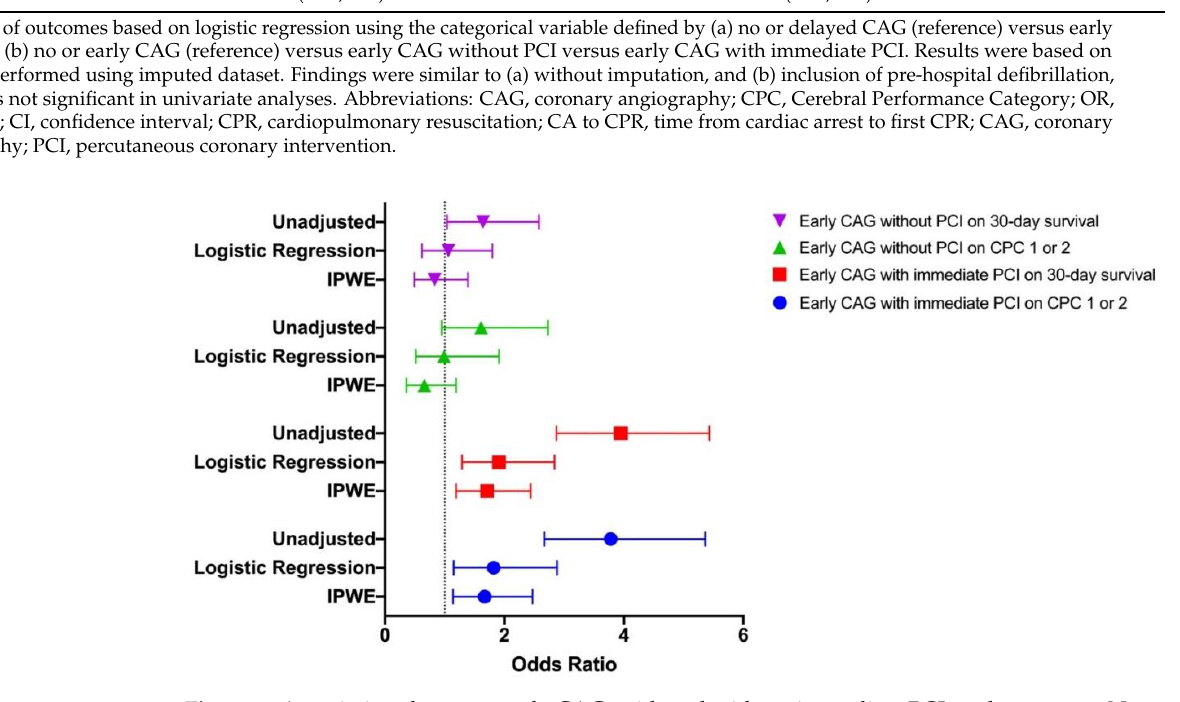
Figure 3. Associations between early CAG, with and without immediate PCI, and outcomes. No or delayed CAG was taken as the reference group. Abbreviations: CAG, coronary angiography; PCI, percutaneous coronary intervention; IPWE, inverse probability weighted estimator; CPC, cerebral performance category.